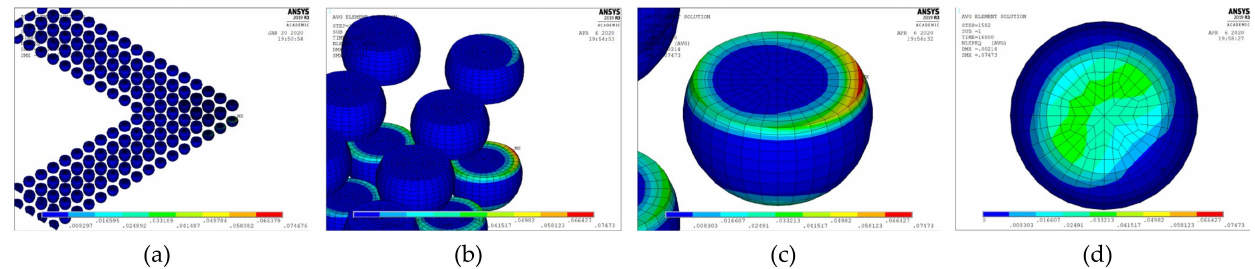
Figure 17. Equivalent inelastic strain distribution in FO ‐ WLP PoP: ( a ) All solder joints; ( b ) location of the maximum strain; ( c ) top view of the solder joint with the maximum DNP; ( d ) bottom view of the solder joint with the maximum DNP.